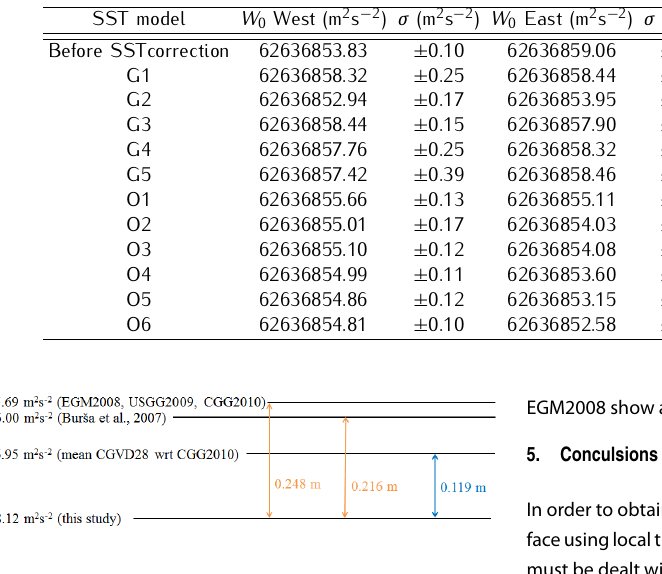
Table 2. Coastal differences in W